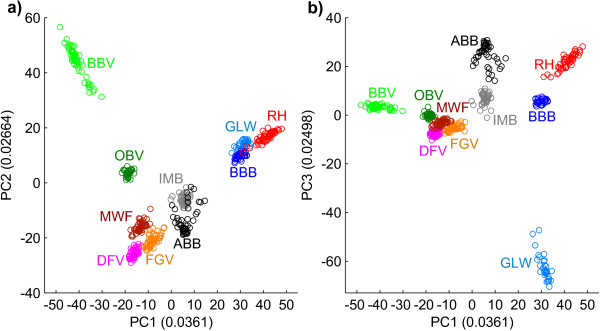
Principal component analysis based on 47,651 genotypes. For all 10 breeds principal components (PC) and their importance (numbers in brackets) are shown. a) PC1 vs. PC2 b) PC1 vs. PC3.